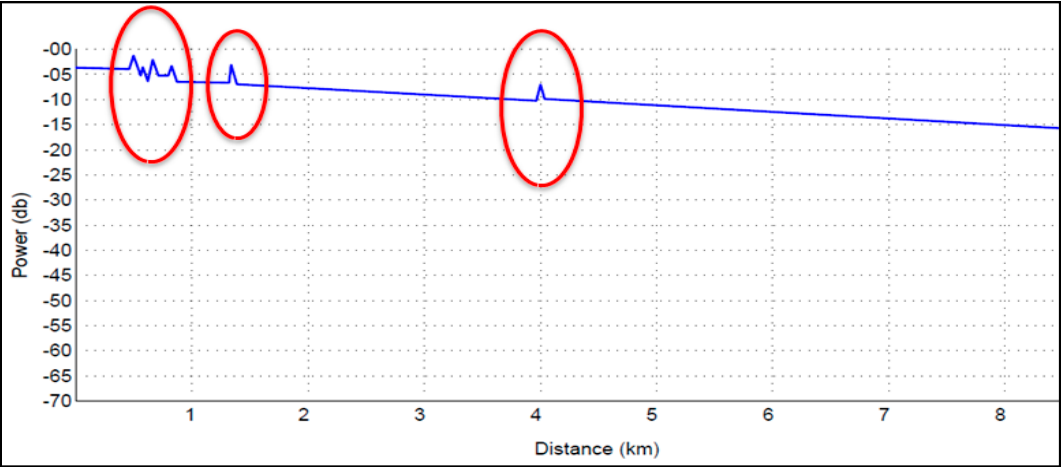
Figure 12. The improving FPMT circuit detected a bending pattern shape at event 6. Table 10. The parameters and practical results detected at event 6. Detection Signals Generated